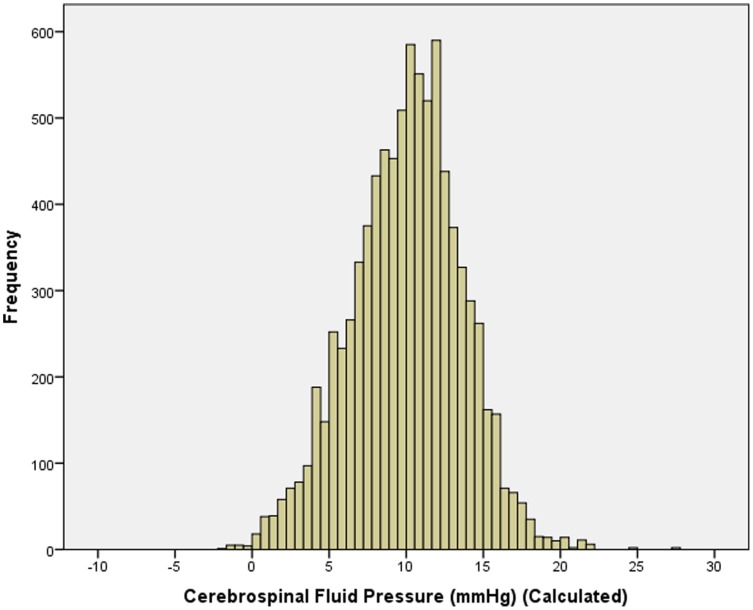
Histogram showing the distribution of the estimated cerebrospinal fluid pressure in the non-glaucomatous eyes of the Central India Eye and Medical Study.